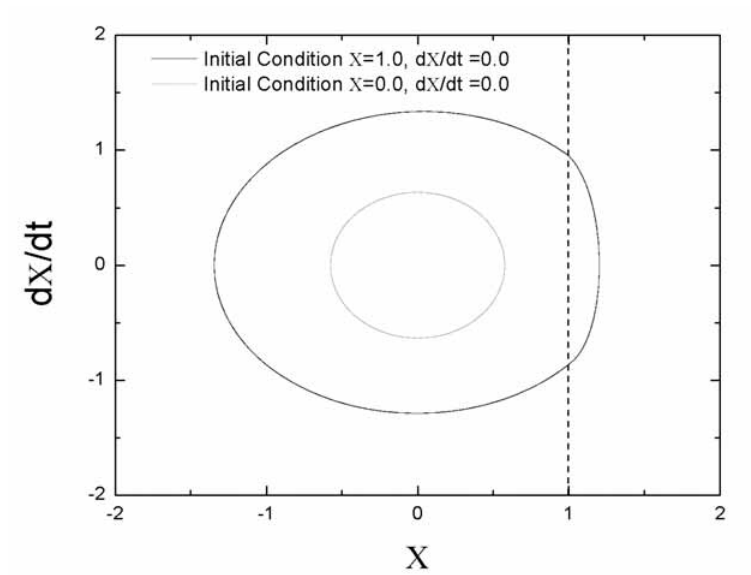
Fig. 8. Coexisting periodic attractors.